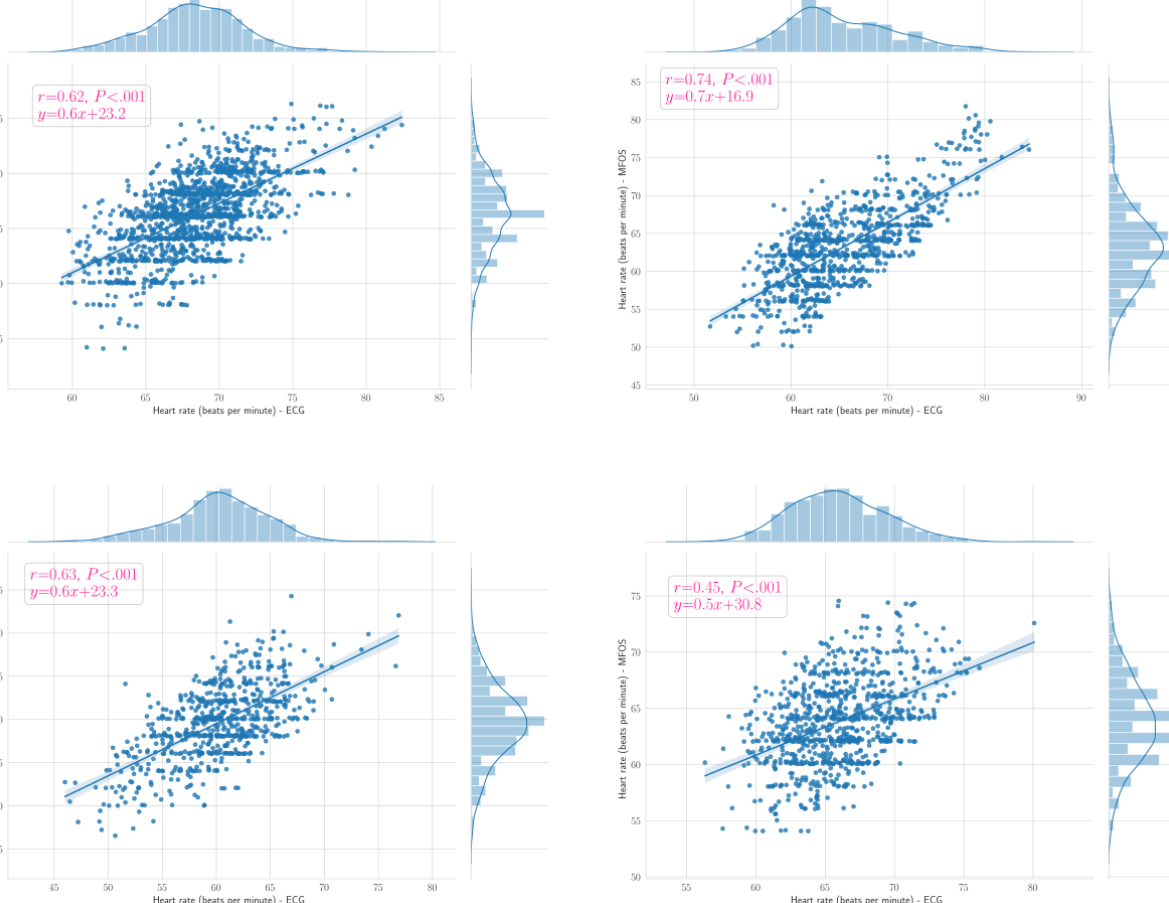
Figure 10. Pearson correlation plots of the heart rates for patients 1, 2, 6, and 10 (ie, top left, top right, bottom left, and bottom right, respectively). The blue circles represent reference heart rate against the estimated heart rate, and the blue line represents the fitted line. ECG: electrocardiogram; MFOS: microbend fiber optic